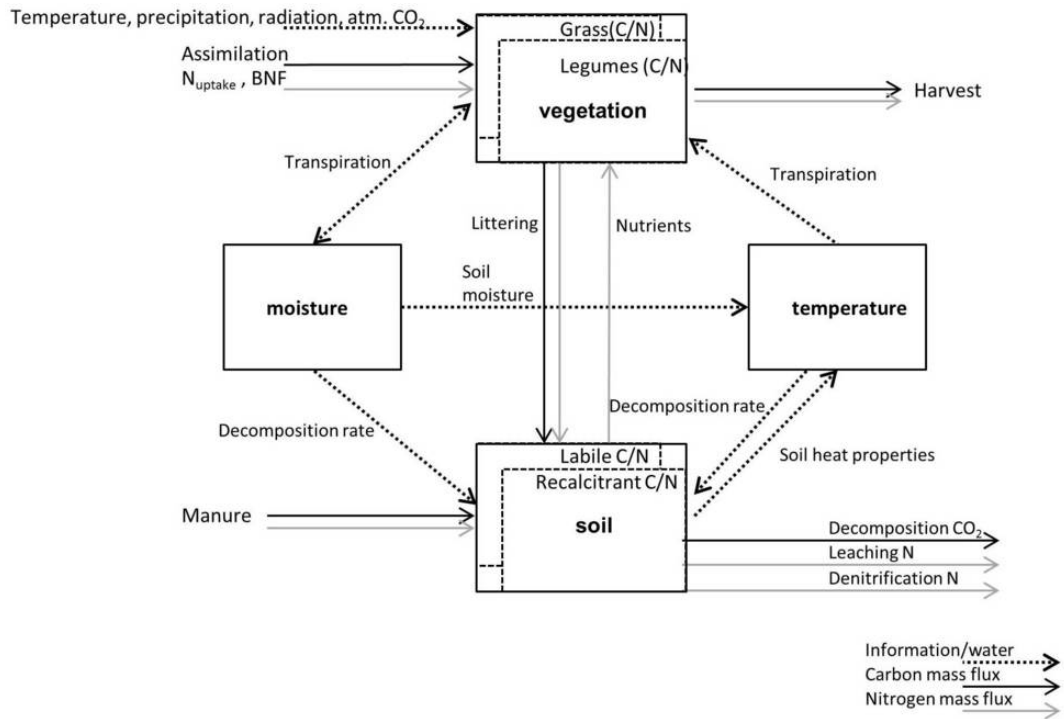
Fig. 1. Overview of the Oensingen Grassland Model. The 4 solid-lined boxes are the main modules. The vegetation module can contain multiple plant functional types (here: grass and legumes in dotted boxes). The soil contains two decomposition pools, expressed in terms of C and N (dotted boxes). Arrows denote relationships between the modules. They can refer either to mass or information